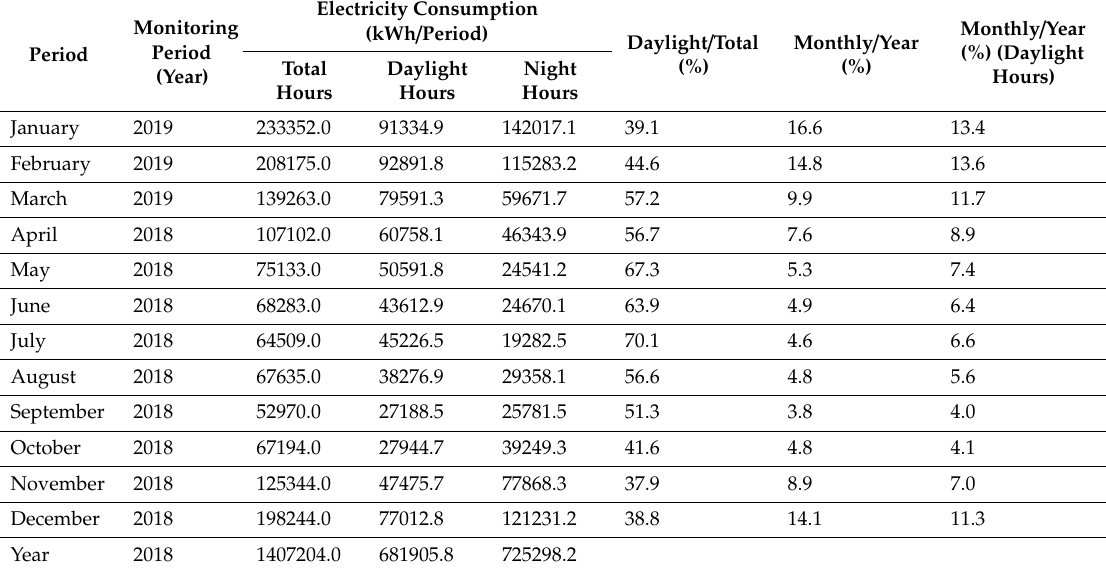
Table 3. Olive mill load